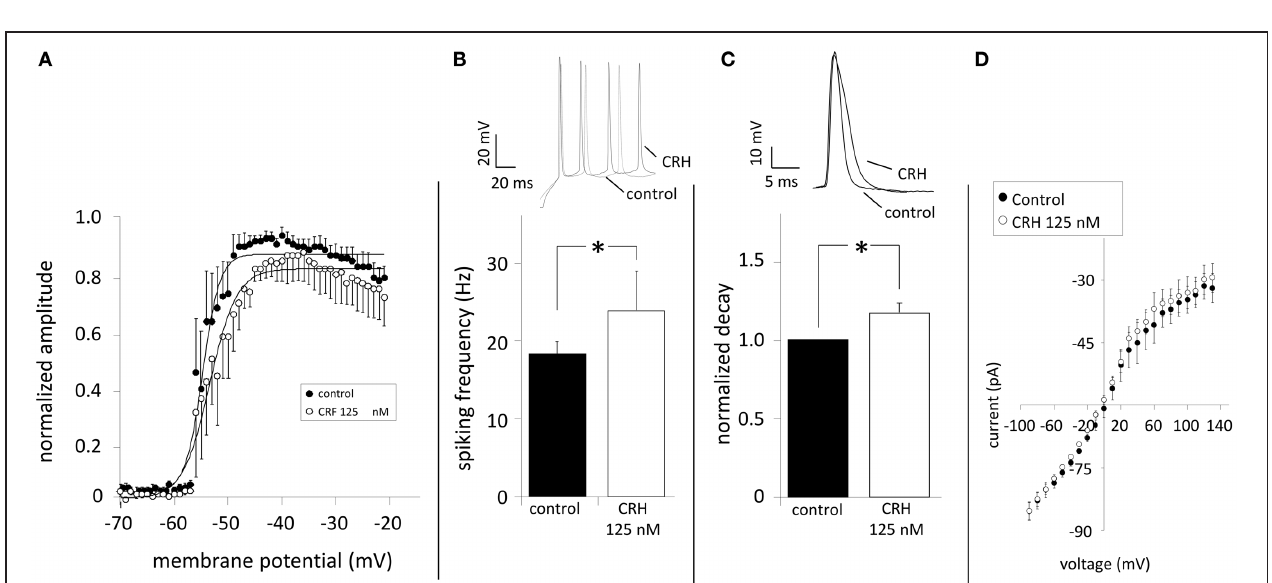
FIGURE 4 | CRH increases intracellular calcium influx in CA1 pyramidal neurons upon electrical stimulation of the Schaffer-collaterals. (A) Cells were loaded with the calcium sensitive dye oregon green-AM. After 1h of incubation, the SC were electrically stimulated every 15s and calcium influx was recorded simultaneously (sampling rate 20Hz; duration 1.5s). In the presence of CRH the intracellular Ca 2 +− influx during synaptic activity increased to 231 . 7 ± 13 . 8% of control ( n = 4; p < 0 . 05). Right insets: Videomicroscopic photograph of the CA1 region of the hippocampus and fluorescence recorded under control conditions (middle) and in the presence